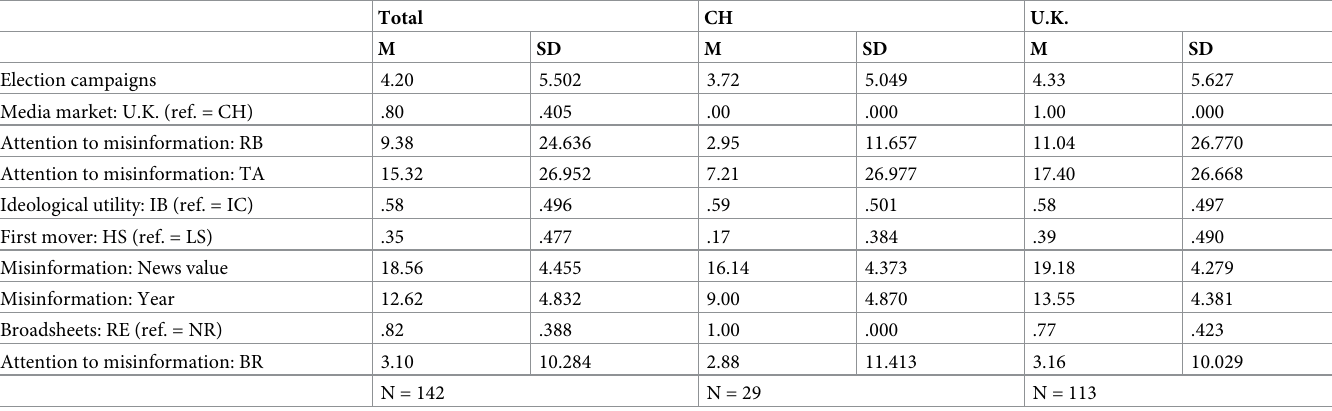
Table 1. Descriptive statistics (political journalism).